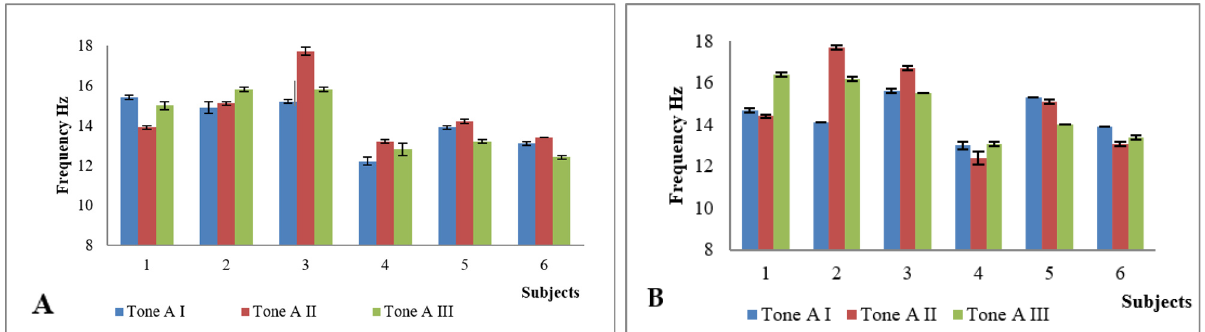
Figure 5. The tone of m. tensor fasciae latae (left ( A ) and right ( B ) leg) in first (I), second (II) and third (III) assessment.